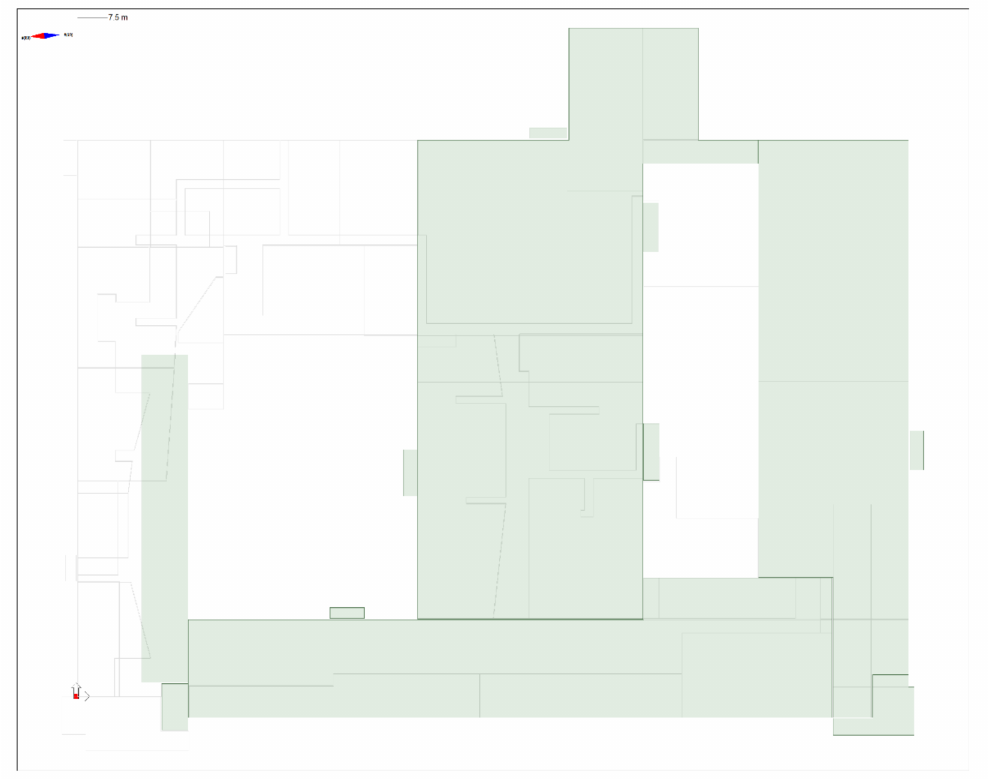
Figure A4. Fourth floor ( z = 13.5